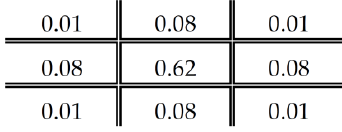
Figure 7. DDBTC Gaussian diffused kernel.